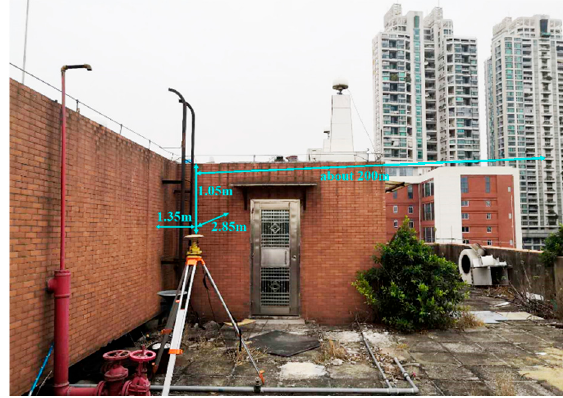
Figure 1. Data collecting site on DOY 310–321, 2018.